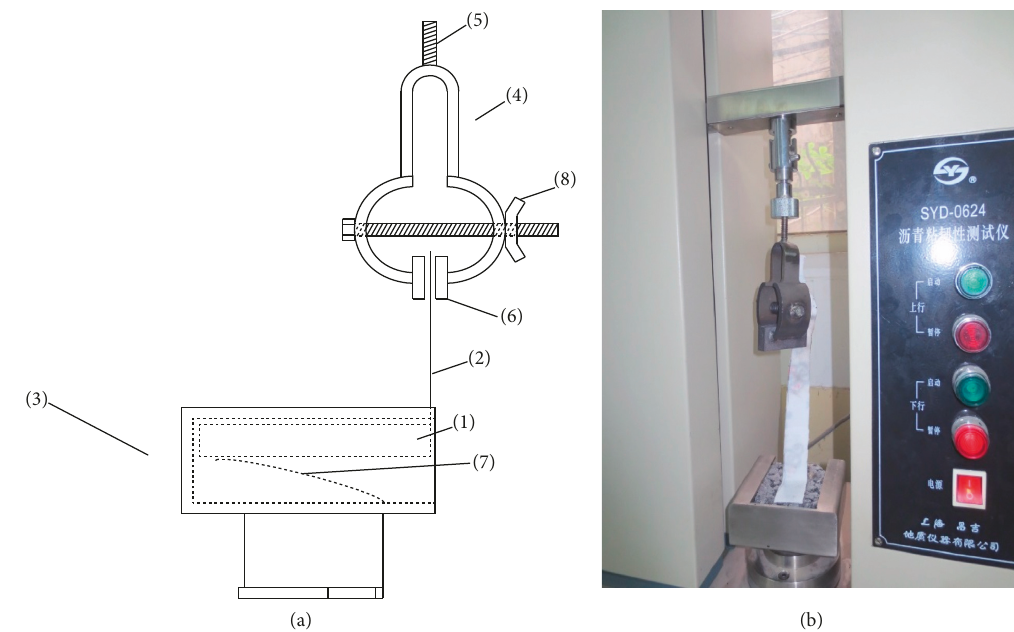
Figure 7: (a) Schematic diagram and (b) physical diagram of the experimental device.